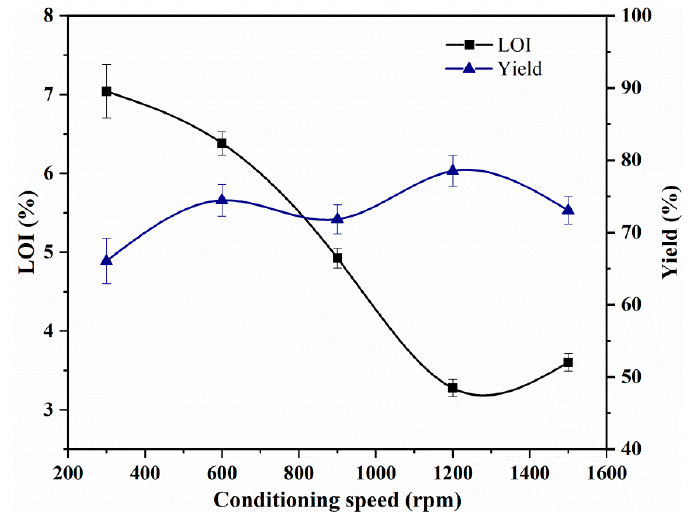
Figure 10. Effect of conditioning speed on the LOI and yield of